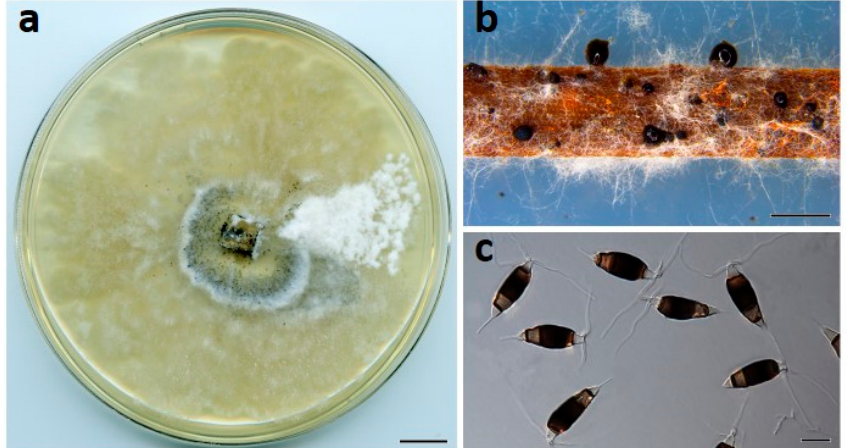
Figure 4. Neopestalotiopsis maddoxii (BRIP 72266a). ( a ) Two-week-old colony on PDA, ( b ) conidiomata on pine needle agar, and ( c ) conidia. Scale bars: a = 1 cm; b = 1 mm; c = 10 µm. Culture characteristics : Colonies on PDA after 7 d at 25 ◦ C reach 70 mm diam., with MycoBank: MB840917. cream aerial mycelium, forming abundant pycnidia near the center after two weeks; reverse cream to